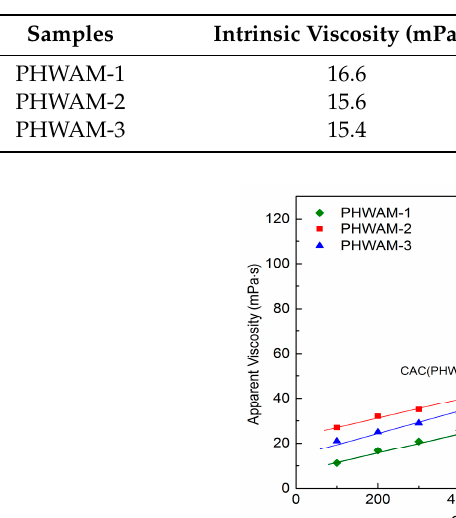
Table 2. The characteristics of the drag reducers samples.